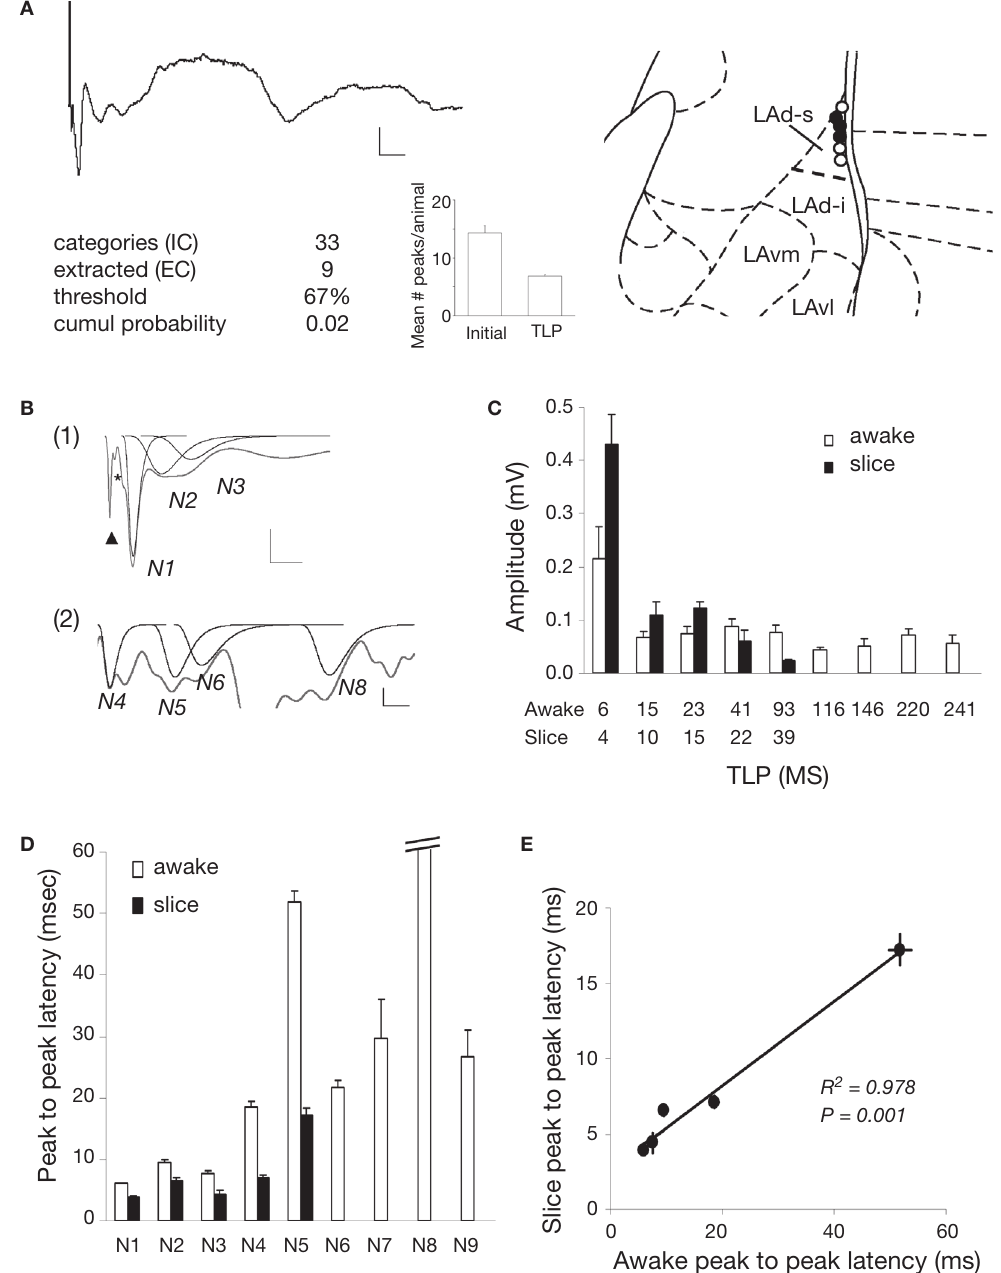
Figure 10 | Comparison with temporally organized polysynaptic LAd network in vivo . (A) Thalamic stimulation in the awake animal evoked in LAd-s a monosynaptic negative potential followed by multiple polysynaptic peaks (voltage trace). Scale = 0.1 mV, 10 ms. Text and histogram show extraction of TLPs detected with non-linear curve fi tting and probabilistic logic (see Materials and Methods). Mean number of peaks per animal is reduced by approximately 50%, indicating that approximately 50% of all peaks detected using the non-linear curve fi tting method are temporally reliable across animals (TLP). Atlas shows the recording electrode placements in the LAd-s. Electrodes are in same anterior–posterior location shown (black) or adjacent anterior–posterior positions (white). (B) Example trace with individual peaks fi tted using non-linear peak fi tting and identifi ed as TLPs. Trace is partially shown to allow clearer observation of arti- fact (arrowhead), presynaptic FV ( * ) and TLPs N1 to N3 in (1) and N4 to N8 in (2). (C) Comparison of in vivo (N1 to N9) and in vitro (N1 to N5) peak amplitudes. (D) Comparison of in vivo and in vitro peak to peak latencies. (E) Linear relationship between in vitro and in vivo peak to peak